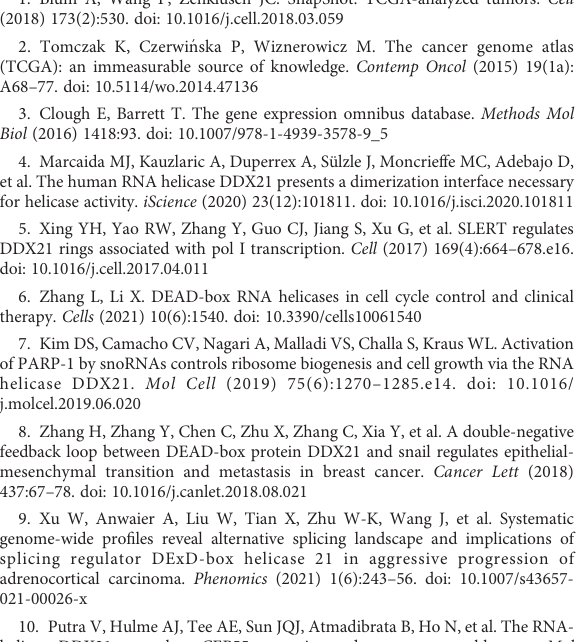
SUPPLEMENTARY FIGURE 1 Work fl ow diagrams for the methodology in this study as well as the work fl ow showing the steps including integration of datasets from various sources. SUPPLEMENTARY FIGURE 2 Work fl ow diagrams for the methodology in this study as well as the work fl ow showing the steps including integration of datasets from various sources. SUPPLEMENTARY FIGURE 3 Expression levels of the DDX21 gene in different tumors. (A − F) The expression status of the DDX21 gene in ACC, BRAC, OV, SARC, TGCT and UCS in TCGA were compared with corresponding normal tissues in GTEx databases. SUPPLEMENTARY FIGURE 4 DDX21 expression status in different normal tissues. (A − C) DDX21 tissue expression based on human protein atlas (HPA), GTEx and function annotation of the mammalian genome 5 (FANTOM5) databases. (D) DDX21 expression in various cell types. SUPPLEMENTARY FIGURE 5 (A − M) SinglecellRNAlevelsofdesignatedcelltypeclustersforeachexamined tissue. The bar chart depicts the amounts of nTPM in each annotated cluster of single cells. The UMAP plot depicts the RNA expression pro fi le on the left. Colorcodingisbasedoncelltypegroupings,whicharemadeupof celltypes that share functional characteristics. Note that the same cell type may be present in multiple clusters. SUPPLEMENTARY FIGURE 6 (A,B) CorrelationanalysisbetweenDDX21expressionandimmunein fi ltration of CD8 + T-cells. Different algorithms were used to explore the potential correlation between the expression level of the DDX21 gene and the in fi ltration level of CD8 + T-cells across all types of cancer in